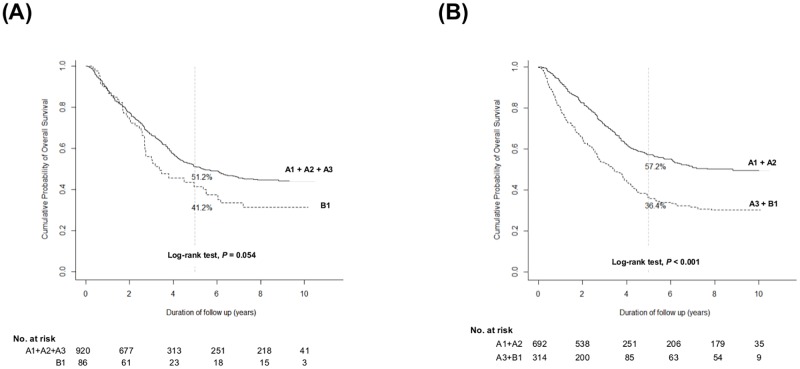
Cumulative overall survival rate of each subgrouping after IPW.(A) Overall survival rates according to subgrouping 1 (A1 + A2 + A3 vs. B1) after IPW (B) Overall survival rates according to subgrouping 2 (A1 + A2 vs. A3 + B1) after IPW.